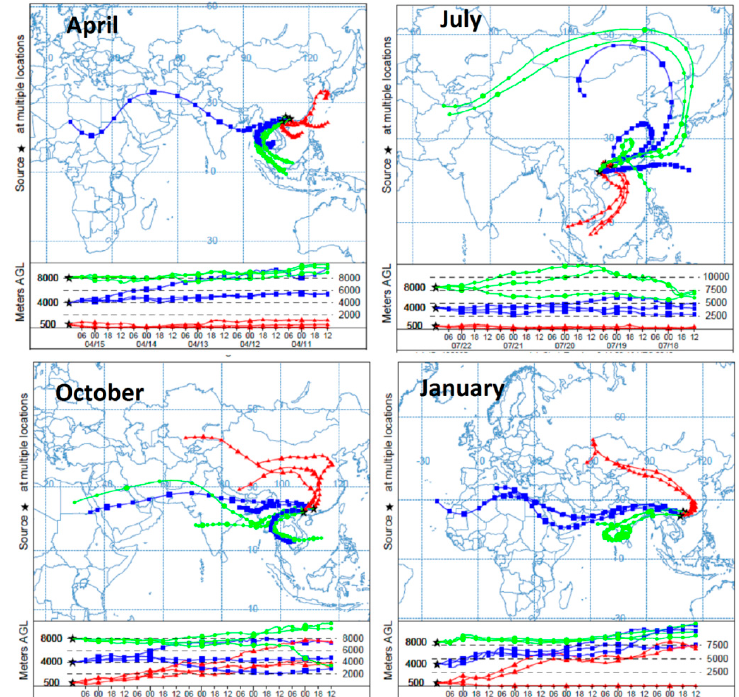
Figure 14. HYSPLIT model results with 120 h backward trajectory for air masses over GX with source locations at 500 m, 4000 m and 8000 m altitudes in April, July, October and January